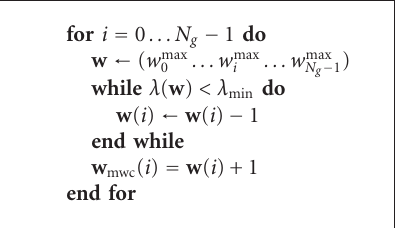
Algorithm 1: Determination of the minimal word-length combi-